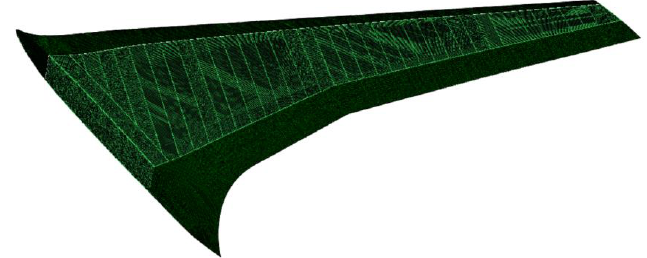
Figure 3. Meshed model of the BWB wing assembly.